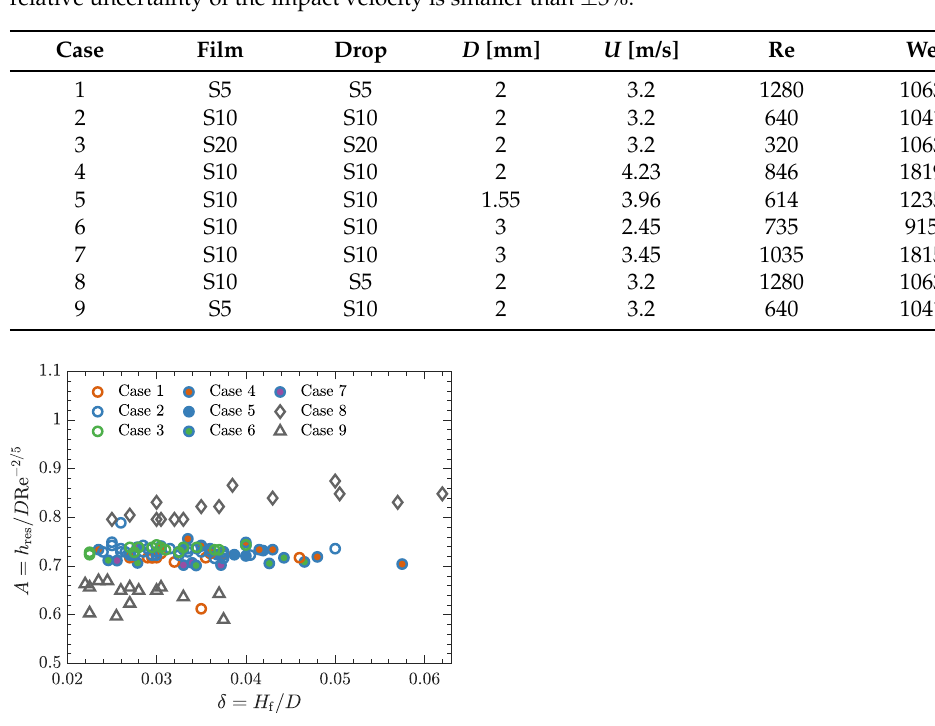
Table 2. Variations of the initial drop diameter D , impact velocity U and drop and film liquids in the experimental campaign. The relative uncertainty of the drop diameter is below below ± 2.5% and the relative uncertainty of the impact velocity is smaller than ± 3%.